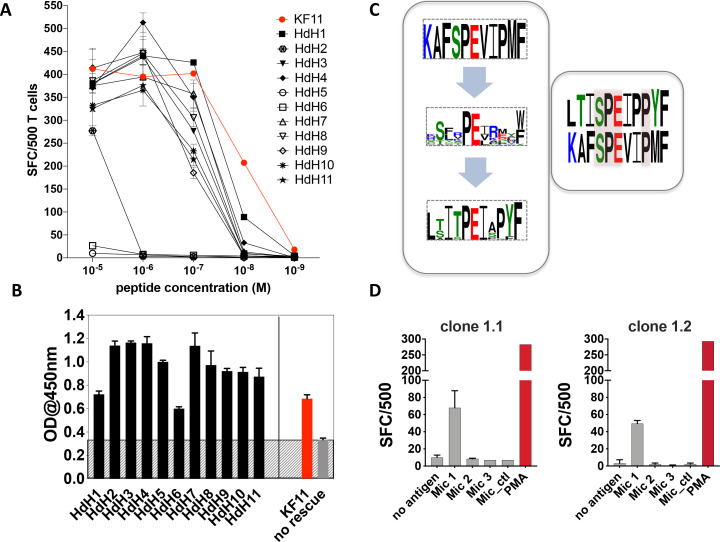
Recognition of haloacid dehydrogenase (HdH) peptides and bacterial lysate-derived antigen by AGA1-expressing T cell clones.(A) Ten non-redundant ('nr') database-mined HdH peptides with close homology to S. newyorkensis peptide (Mic 1/HdH1) were tested in an IFN-γ based ELISpot assays using an AGA1-expressing T cell clone. Peptide concentration (Molar (M)) is denoted on the X-axis and the numbers of Spot Forming Cells (SFC) per 500 cell input is displayed on the Y-axis. Responses to the KF11 epitope are noted in red. Assays were performed in duplicate (technical repeats) on two separate occasions using different peptide stock dilutions and following re-stimulation and resting of T cell clone 1.2 (biological repeats), with one representative shown here. Error bars corresponding to the Standard Error of the Mean (SEM) reported. Test peptide IDs, their origins and sequence identities are specified in Table 2. (B) Binding of the HdH peptides to HLA-B*57:01, assessed in the UV-mediated peptide exchange sandwich ELISA assay. The Y-axis denotes average absorbance readings at 450 nm and the X-axis denotes test peptides. The background corresponding to the no peptide rescue (nr) control is denoted in grey (also illustrated across the samples by grey hatching). Assays were performed in duplicate (technical repeats) on two separate occasions using different peptide stock dilutions (biological repeats, n = 2), with one representative shown here. Error bars corresponding to the Standard Error of the Mean (SEM) are reported. Test peptide IDs, their origins and sequence identities are specified in Table 2. (C) Summary of evolved peptide motifs recognised by the AGA1 TCR. Recognition beyond the original KAFSPEVIPMF (KF11) index motif is exemplified initially by the diverse peptide sequences retrieved during repeated rounds of AGA1 TCR-mediated peptide selection, with a Seq2Logo motif reported for the top 20 Round 3 evolved peptide libraries. Following evaluation of 'nr'-database derived peptides in T cell functional assays, peptides that elicited the strongest functional responses - in this case, a S. newyorkensis-derived haloacid dehydrogenase peptide -allowed further refinement of database-led search motifs and identification of related peptide that were functionally recognized by AGA1 TCR-expressing T cell clones. Amino acids shared between KF11 and the S. newyorkensis-derived Mic1/HdH1 peptide is illustrated in the smaller right panel (pink shading). (D) Recognition of bacterial cell lysates from S. newyorkensis (Mic 1), C. orthopsilosis (Mic 2), O. uli (Mic 3) and R. gnavus (control) by AGA1-expressing T cell clones 1.1 and 1.2 was tested using an IFN-γ based ELISpot assay. Bacterial cell lysates (20μg/mL) were incubated with cytokine-matured HLA-B*57:01 positive HL60 cells for 7 hours, following which T cell responses were evaluated. PMA (10ng/mL) was included as a positive control, and the background control comprised HL60 cells incubated with T cells only. Lysate identity is denoted on the X-axes and the numbers of Spot Forming Cells (SFC) per 500 cell input are displayed on the Y-axes. Assays were performed in duplicate (technical repeats, n = 2) on two separate occasions (biological repeats, n = 2) using fresh lysate stock dilutions and following re-stimulation and resting of T cell clones 1.1 and 1.2. One representative is shown.
Figure 4—source data 1.AGA1+ T cell clone 1.2 recognition of 'nr' mined HdH peptides_ELISpot data.

Figure 4—source data 2.UV-exchange HLA-B*57:01 peptide binding ELISA data for HdH peptides.

Figure 4—source data 3.Recognition of S. newyorkensis bacterial lysates by AGA1+ T cell clones 1.1 and 1.2_ELISpot data.